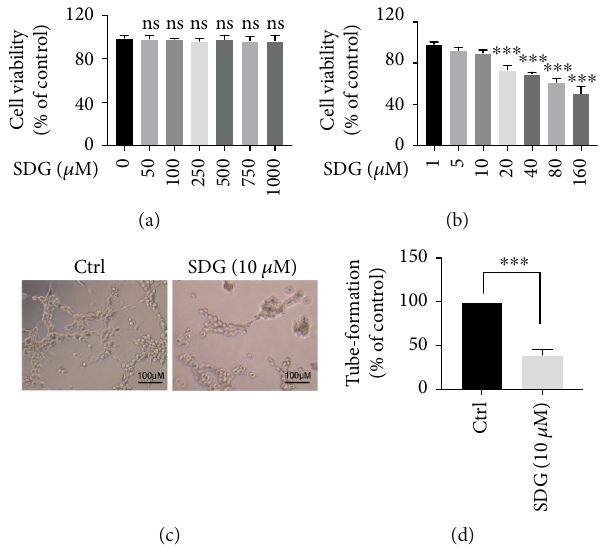
Figure 1: The e ff ect of SDG on HUVEC viability reduces the angiogenic capacity of HUVECs. (a, b) HUVECs are treated with SDG in graded concentrations at lower doses (0, 50, 100, 250, 500, 750, or 1000 nM) and at higher doses (1, 5, 10, 20, 40, 80, and 160 μ M); then, cell viability was measured by CCK-8 assay. Compared to the 0 μ M or 1 μ M group, ∗∗∗ represents p < 0 : 0001 . (c, d) SDG (10 μ M) reduces the angiogenic capacity of HUVECs. Error bars represent mean ± s : d . ∗∗∗ represents p < 0 : 001 . All experiments were performed in triplicate. LPS: lipopolysaccharide; SDG: secoisolariciresinol